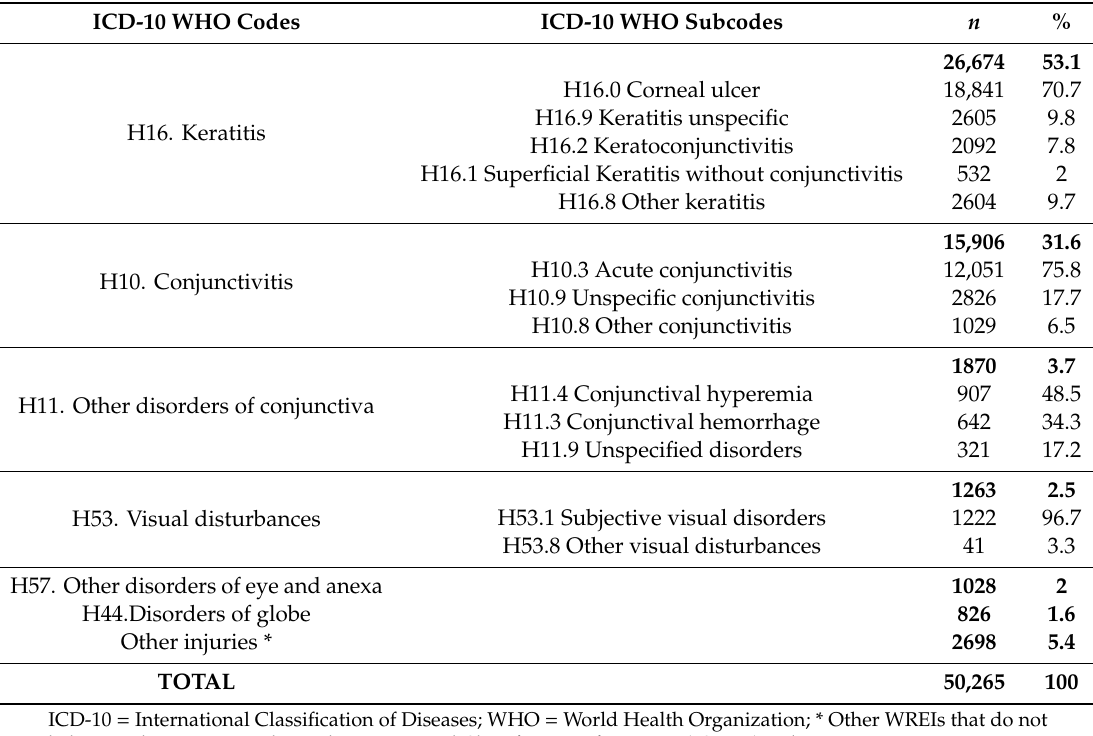
Table 2. Work-related eye injuries classified by the ICD-10 codes and subcodes between 2008 and